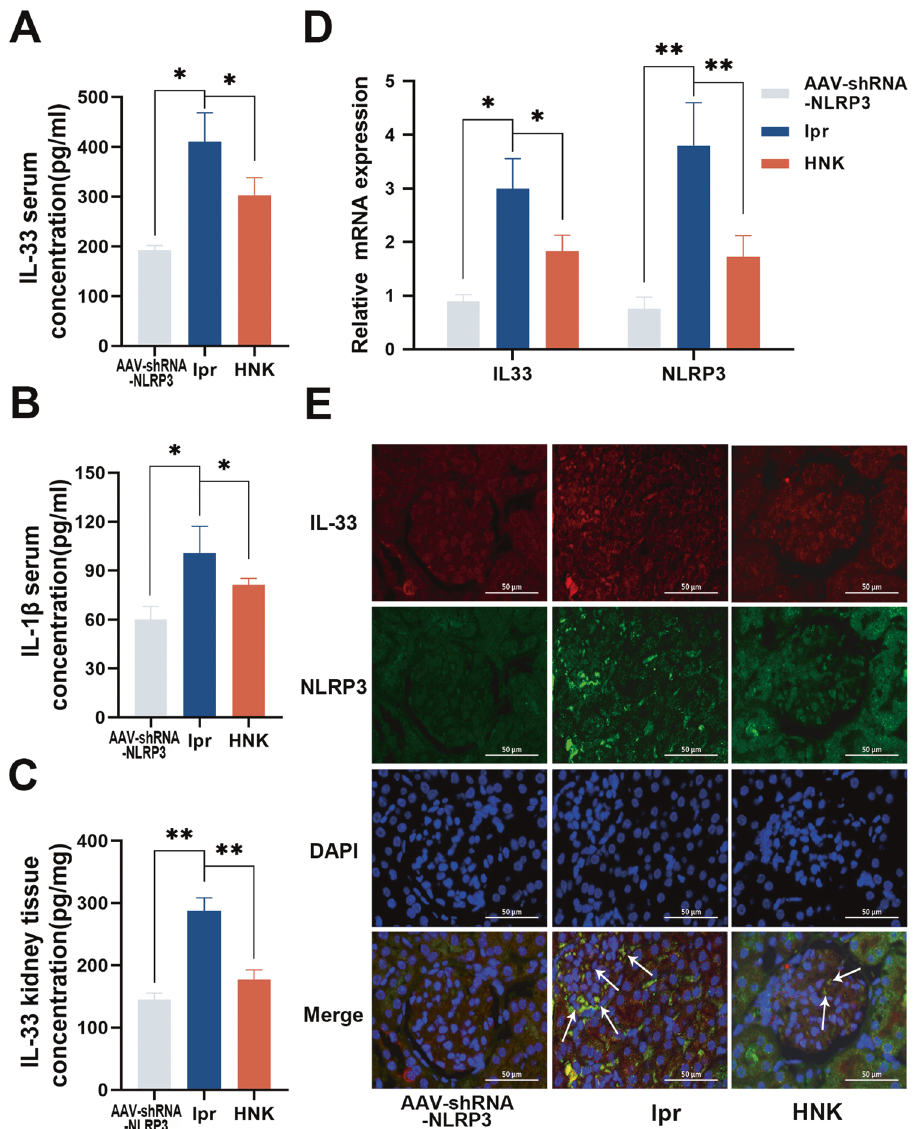
Fig. 4 Honokiol (HNK) suppressed the renal activation of the NLRP3 in fl ammasome and IL-33/ST2 pathway in MRL/lpr mice. A Serum IL- 33 levels. B Serum IL-1 β levels. C Renal IL-33 levels. D HNK decreased the mRNA levels of IL33 and NLRP3 in MPJ/lpr mice. E Immuno fl uorescence co-staining for ST2 and NLRP3. 400×; scale, 50 µm ( n = 6. * p < 0.05, ** p <